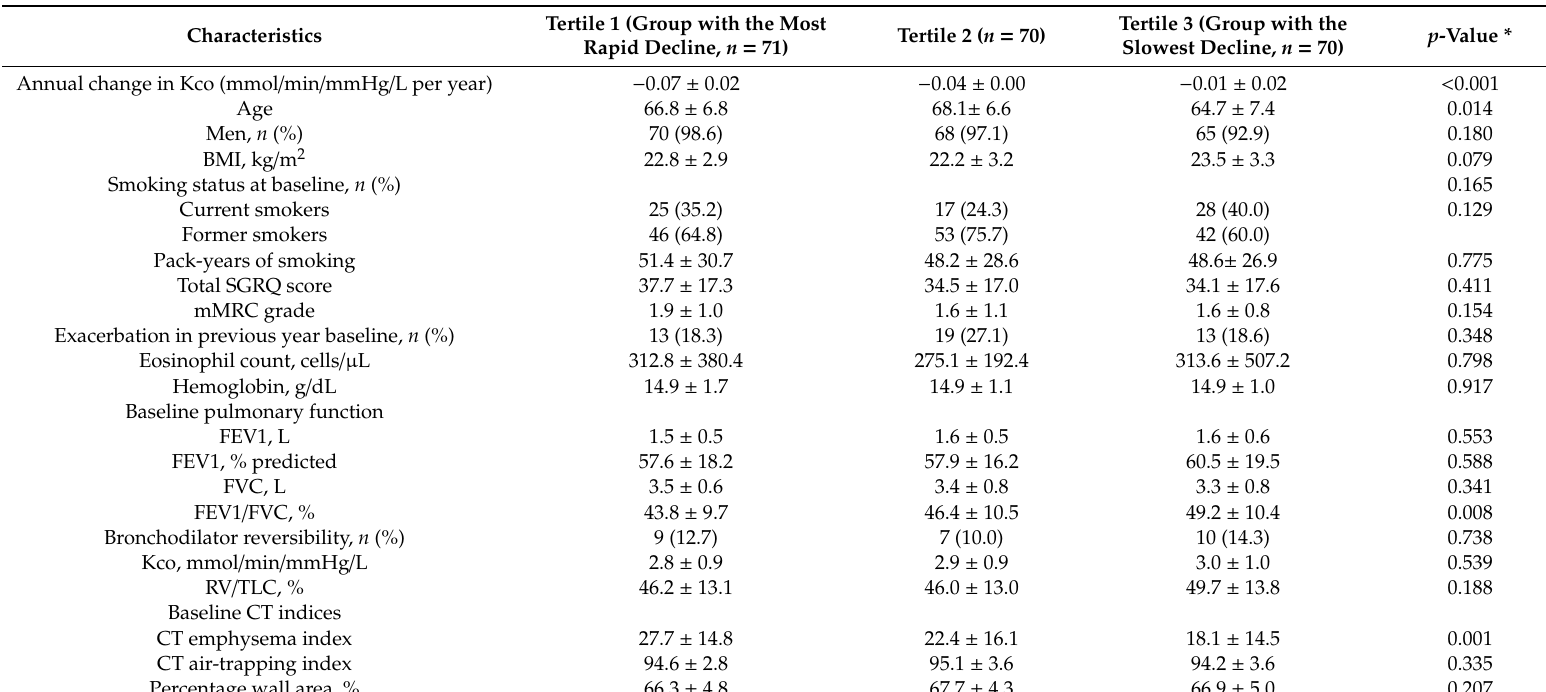
Table 1. Baseline characteristics of patients with COPD classified by annual rates of decline in